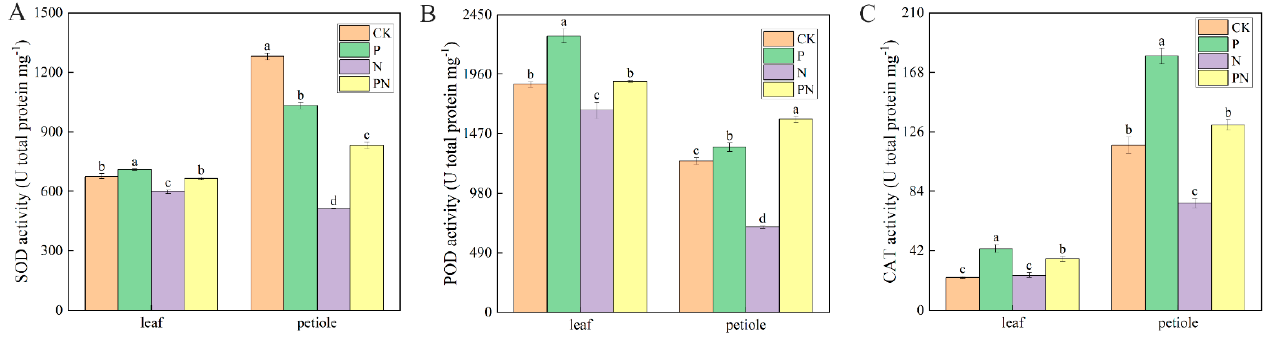
Figure 8. Antioxidant enzyme activity of celery under salt stress as affected by exogenous proline. After planting the 35-day-old seedlings for 7 days, they were treated with 0.3 mM proline solution for 7 days, after which they were watered with 100 mM NaCl solution thrice every 3 days. ( A ) SOD activity. ( B ) POD activity. ( C ) CAT activity. The results are expressed as the mean ± SE of three replicates, and the different letters denote the significant difference among treatments ( p < 0.05), according to Duncan’s multiple tests. CK, control. P, 0.3 mM proline. N, 100 mM NaCl. PN, 100 mM NaCl+ 0.3 mM proline.